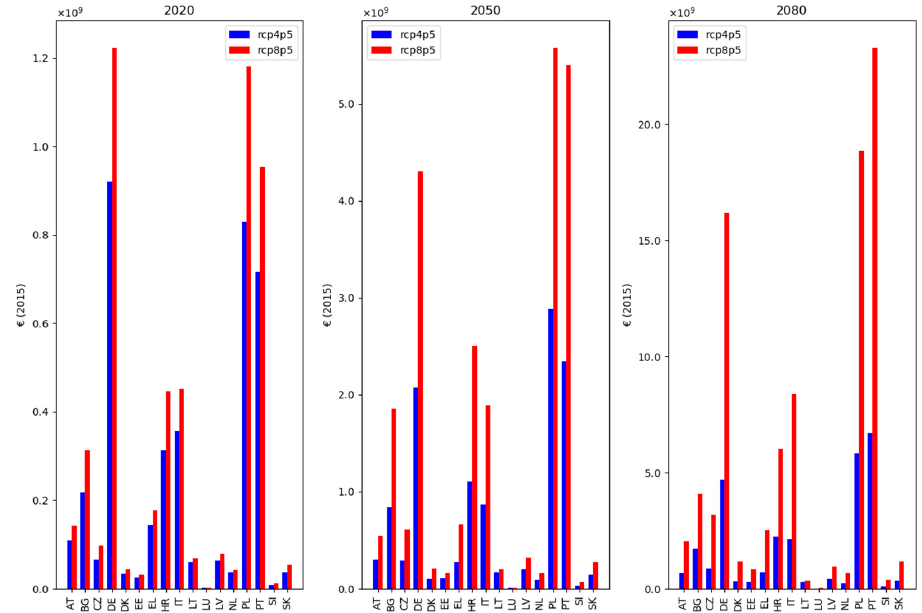
Figure A4. Uninsured annual flood risk for EU countries with voluntary insurance systems, under hard reinsurance market conditions, for RCP4.5 (blue) and RCP8.5 (red), for 2020, 2050, and 2080. Countries that provide public reinsurance for flood insurance are excluded here, as these are not exposed to global reinsurance market volatility resulting from large natural catastrophes. Additionally, countries with semi-voluntary insurance systems are excluded here, since insurance uptake is a mortgage requirement and is therefore less responsive to capital market shocks.